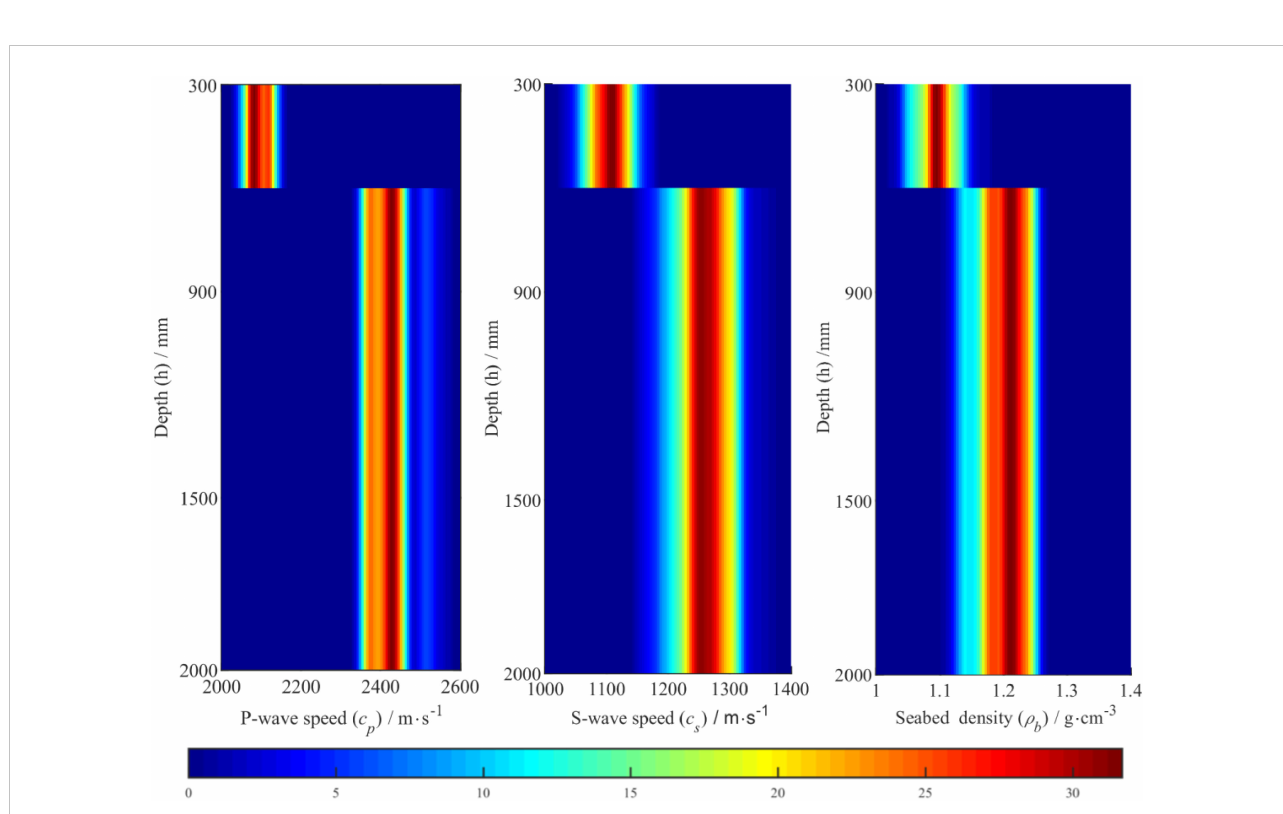
FIGURE 16 Two-dimensional marginal probability distribution. (A-C) two-dimensional edge probability distribution of compression wave speed, shear wave speed and density with depth.